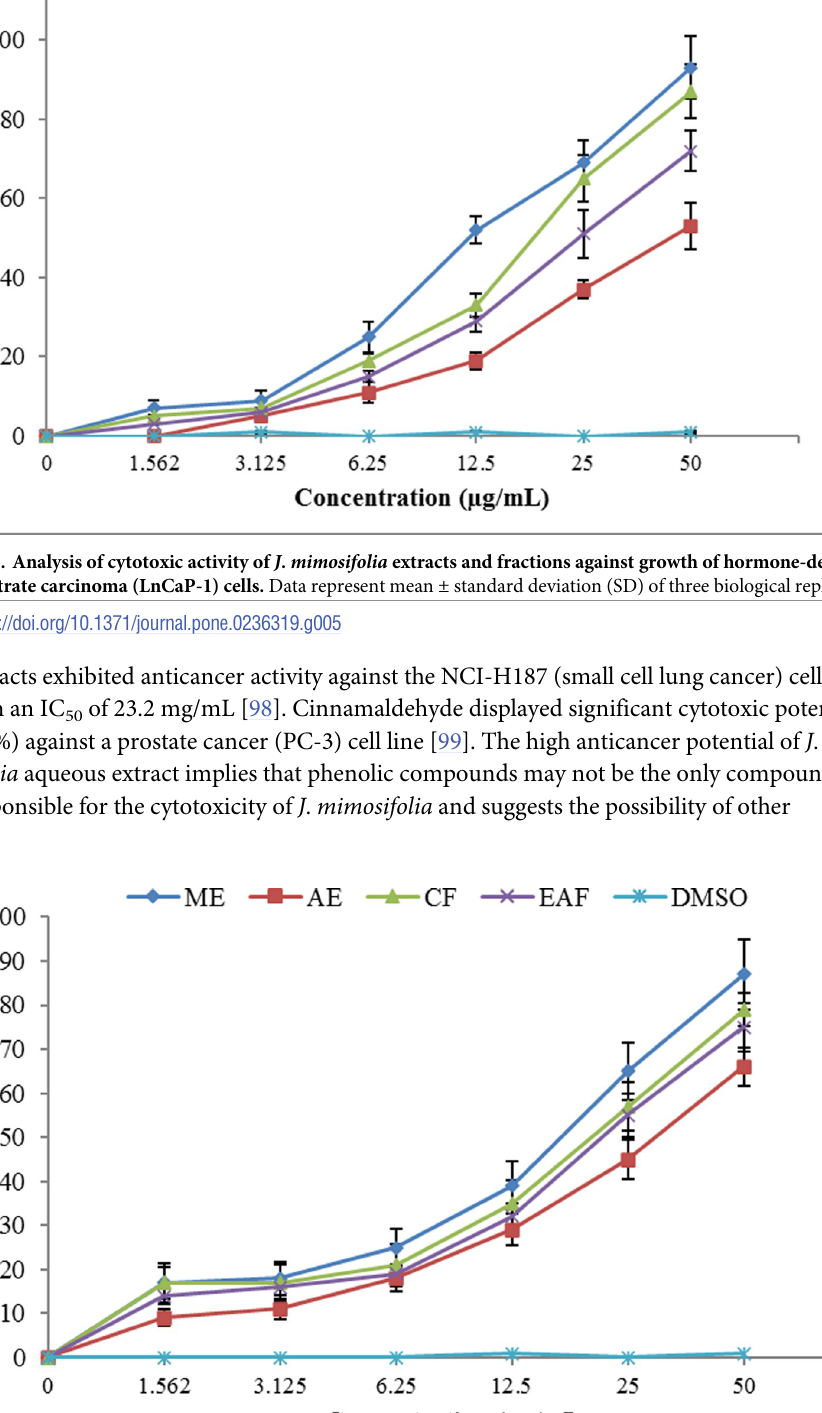
Fig 6. Analysis of cytotoxic activity of J . mimosifolia extracts and fractions against growth of human lung carcinoma (LU-1) cells. Data represent mean ± standard deviation (SD) of three biological replicates.